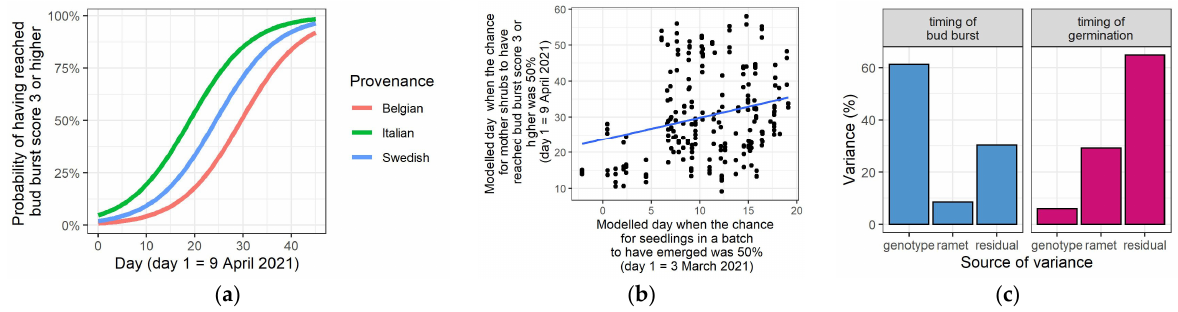
Figure 6. Modelled timing of bud burst on the mother shrubs in the spring of 2021, according to the provenance ( a ). Scatter plot comparing the modelled days when the chance for seedlings to have emerged was 50% with the modelled days when the chance for the mother shrubs to have reached at least bud burst score 3 was 50%. Linear regression line is shown ( b ). Partitioning of variance for bud burst and seedling emergence in the spring of 2021 ( c ). Table 6. Statistical analysis of the timing of bud burst on the mother shrubs and the timing of seed- ling emergence, both in the spring of 2021. In the model, the Belgian provenance is the standard to which the Italian (It) and Swedish (Sw) provenances are compared.